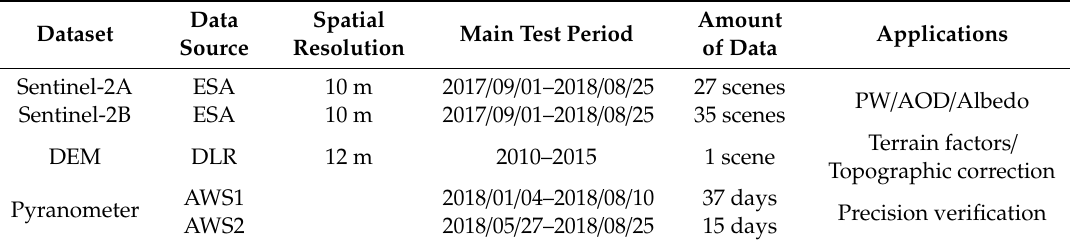
Table 1. Basic information of the multi-source data. PW: precipitable water; ESA: European Space Agency; DEM: digital elevation model; DLR: German Aerospace Center; AWS: automatic weather stations; AOD: aerosol optical